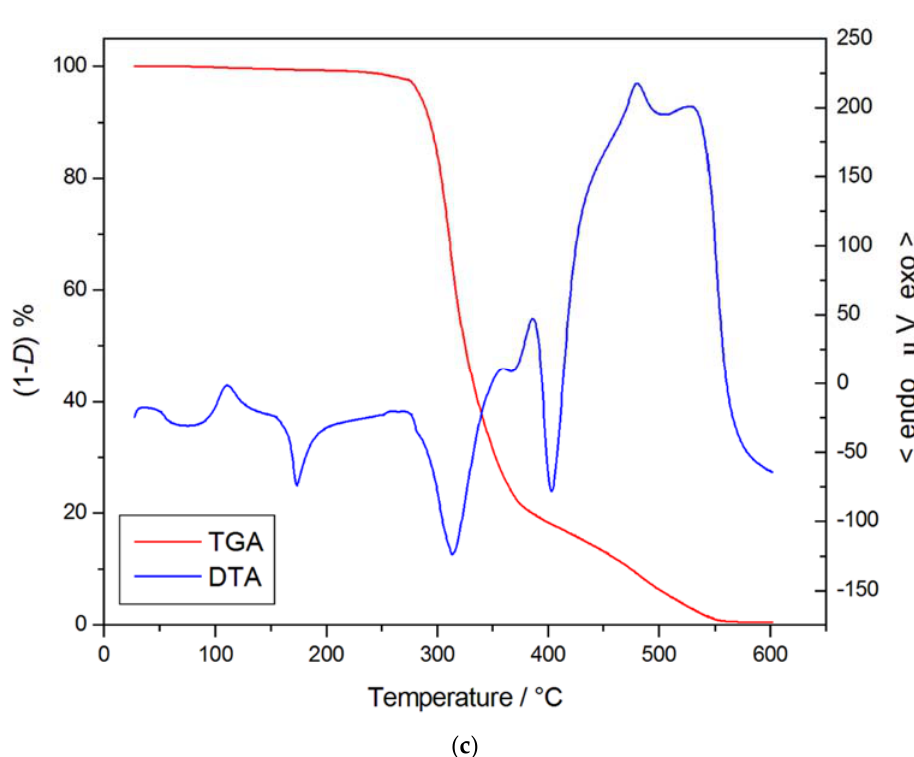
Figure 1. TG/DTA curves for Liquid Wood ( a ), PLA/lignin 10 mass% blend. ( b ) and PLA/lignin 25 mass% blend ( c ). Reprinted from [11] with permission of Springer Nature